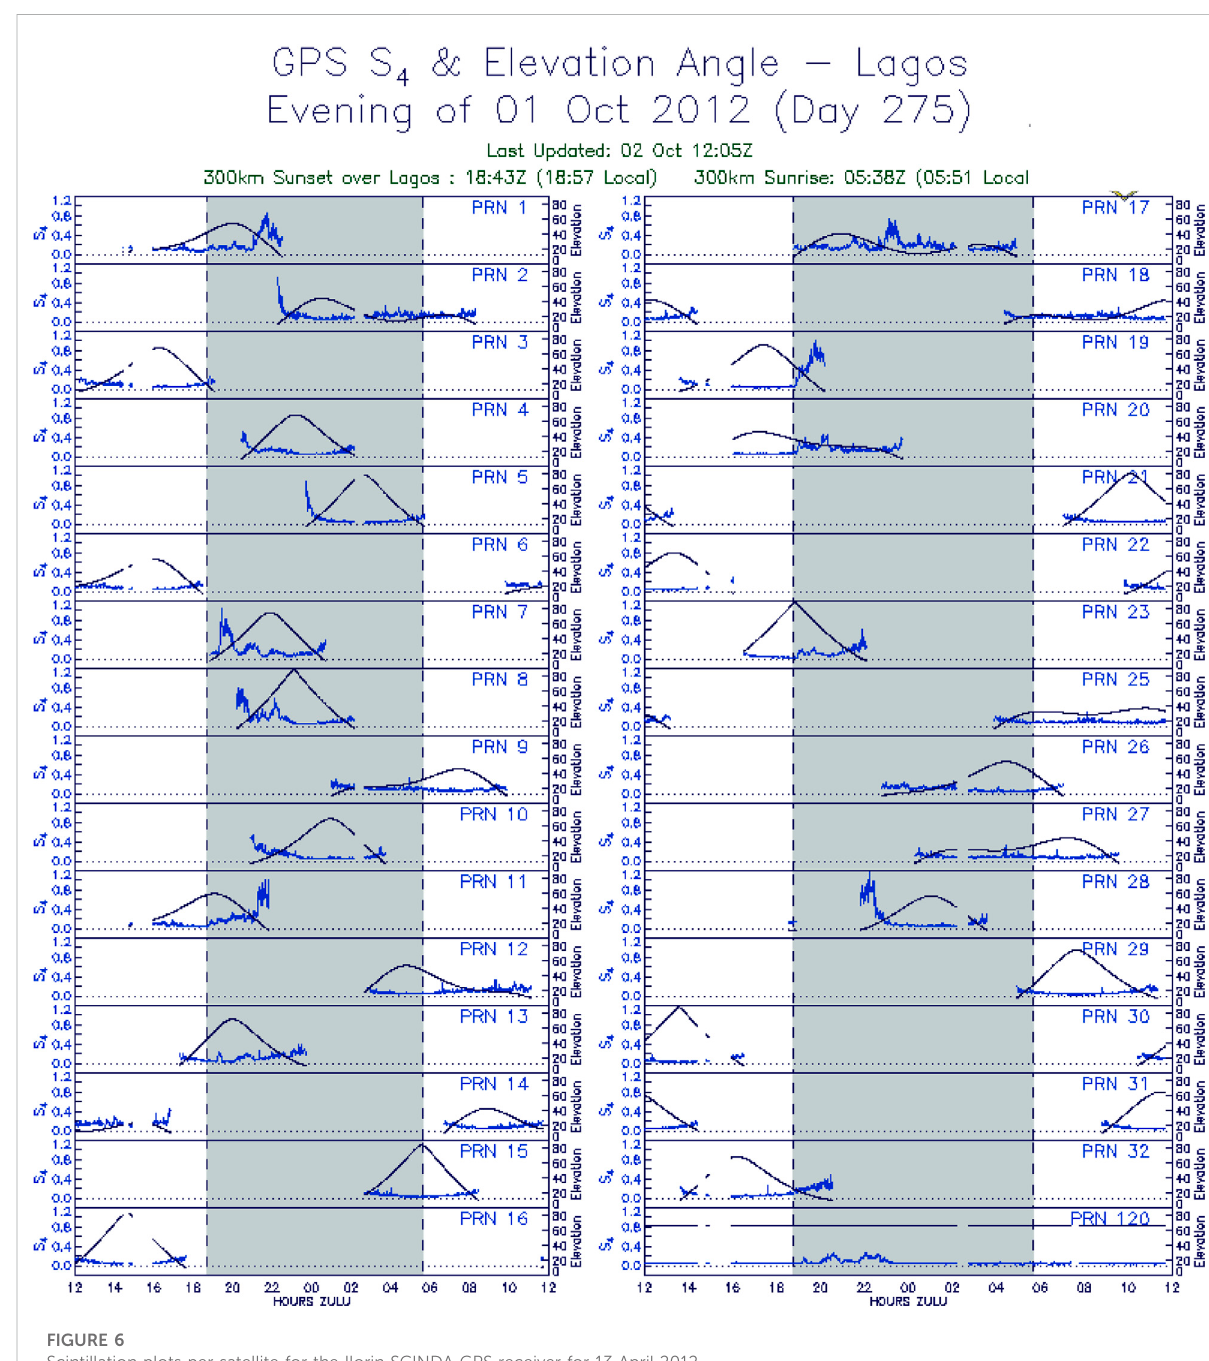
FIGURE 6 Scintillation plots per satellite for the Ilorin SCINDA GPS receiver for 13 April